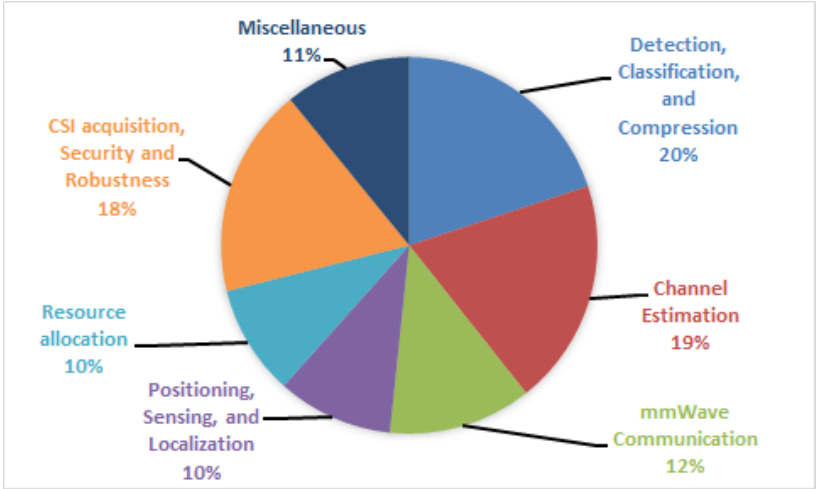
Figure 5. Distribution of the surveyed papers with respect to the different categories.